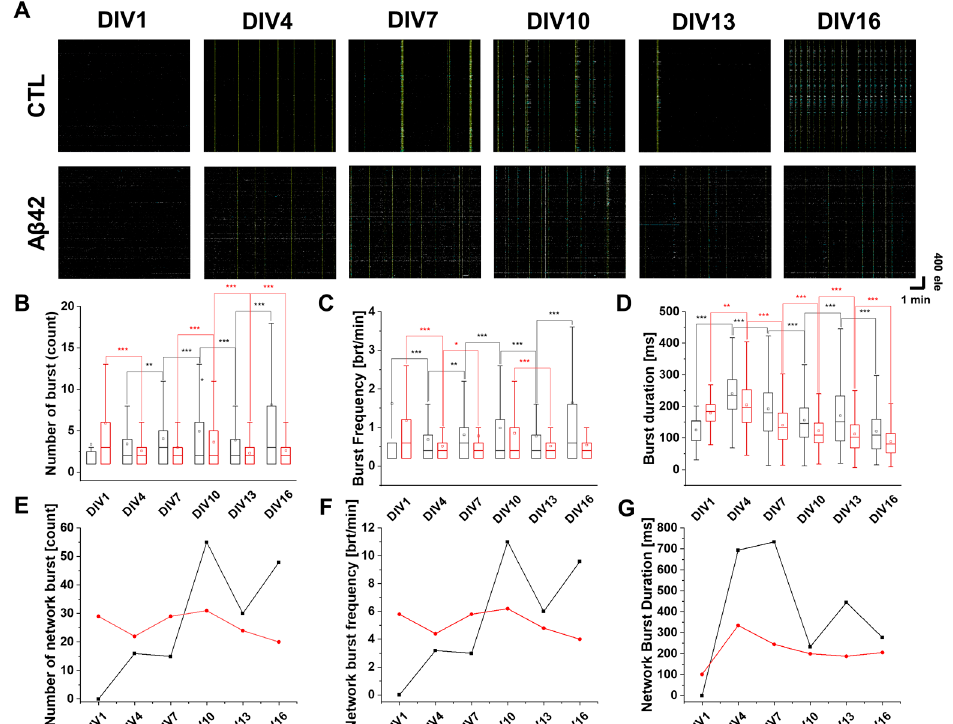
Figure 3. Spike burst analysis in the developing neuronal cultures. ( A ) Raster plot of neuronal spiking from 4096 electrodes (y-axis) during 5 min recordings (x-axis). Control (CTL) and A β 42 oligomer treatment groups in DIV1, 4, 7, 10, 13, and 16. The scale represents one minute and 400 electrodes. The mustard color represents spike network bursts, and blue shows spike bursts. ( B ) Box plot of a number of spike bursts for control (black) and A β 42 oligomer treatment (red) groups. ( C ) Box plot of spike burst frequency showing number of bursts per minute. ( D ) Box plot of spike burst duration in milliseconds. ( E ) Line plot of the number of network bursts for control (black) and A β 42 oligomer treatment (red) groups. ( F ) Line plot of network burst frequency in the number of network bursts per minute. ( G ) Line plot of network burst duration in milliseconds. In all the box plots above, the lower quartile as the borderline of the box nearest to zero expresses the 25th percentile, whereas the upper quartile as the borderline of the box farthest from zero indicates the 75th percentile. Error bars show SEM. *** p < 0.005, ** p < 0.01, * p < 0.05; unpaired, two-tailed t -test with Welch’s correction.